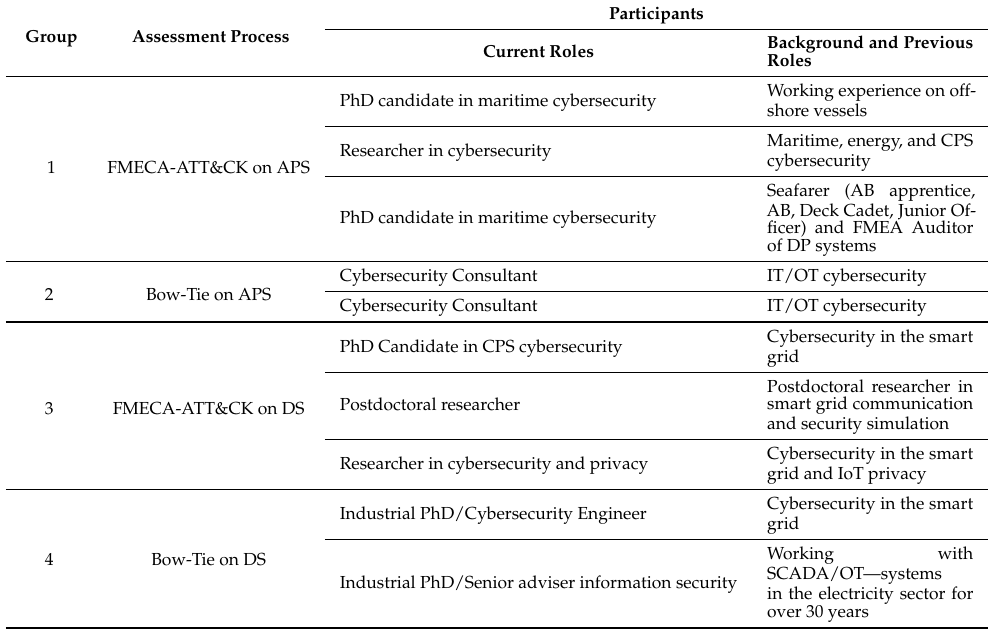
Table 2. Experts roles and